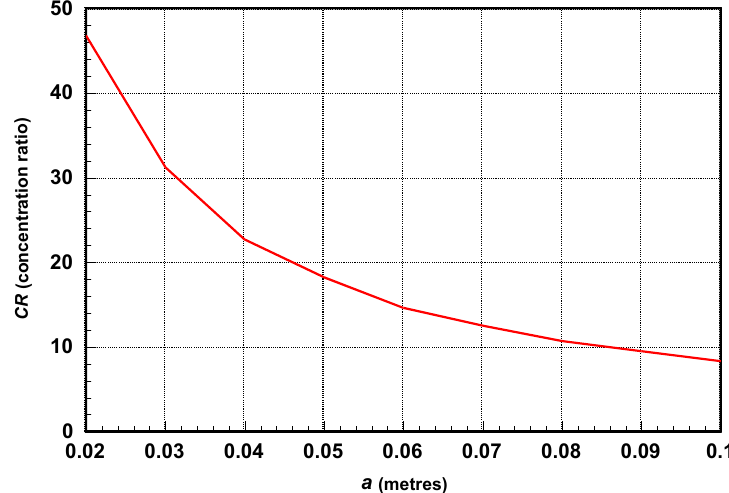
width a of the absorber, at F = 1.0 m and W = 1.7 m. The resulted distribution of LCR on the horizontal